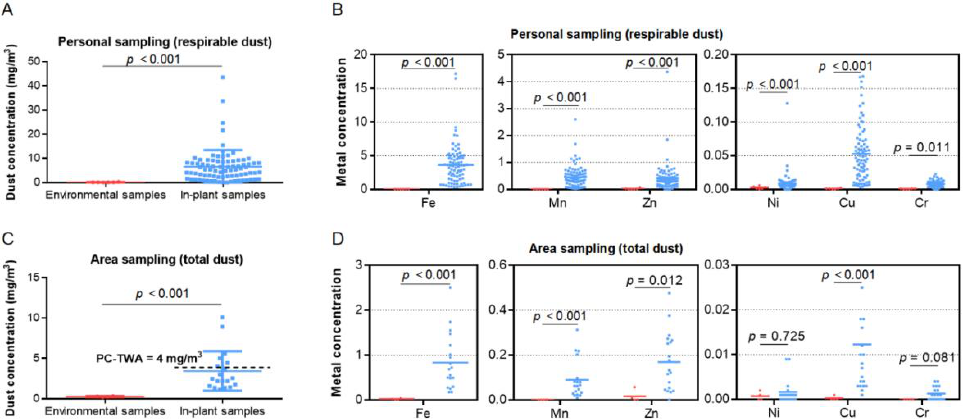
Figure 2. Concentration (mg/m 3 ) and content of welding dust. ( A , B ) Concentrations of respirable dust and six metals in environmental air samples (red) and in-plant air samples (blue) collected by personal sampling method. ( C , D ) Concentrations of total dust and six metals in environmental air samples (red) and in-plant air samples (blue) collected by area sampling method, with 4 mg/m 3 as the national standard (GBZ 2-2007) for total dust concentration of welding fume. The units for Fe, Mn, Zn, Ni, Cu, and Cr are μg/m 3 . PC-TWA, permissible concentration – time weighted average.